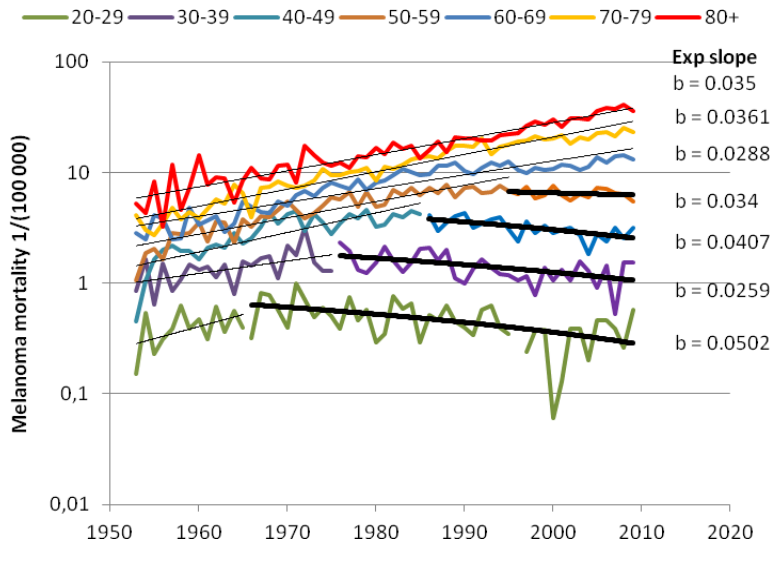
Figure 21. The melanoma mortality among men in the Nordic countries is increasing exponentially as a function of time lived in the Nordic environment after